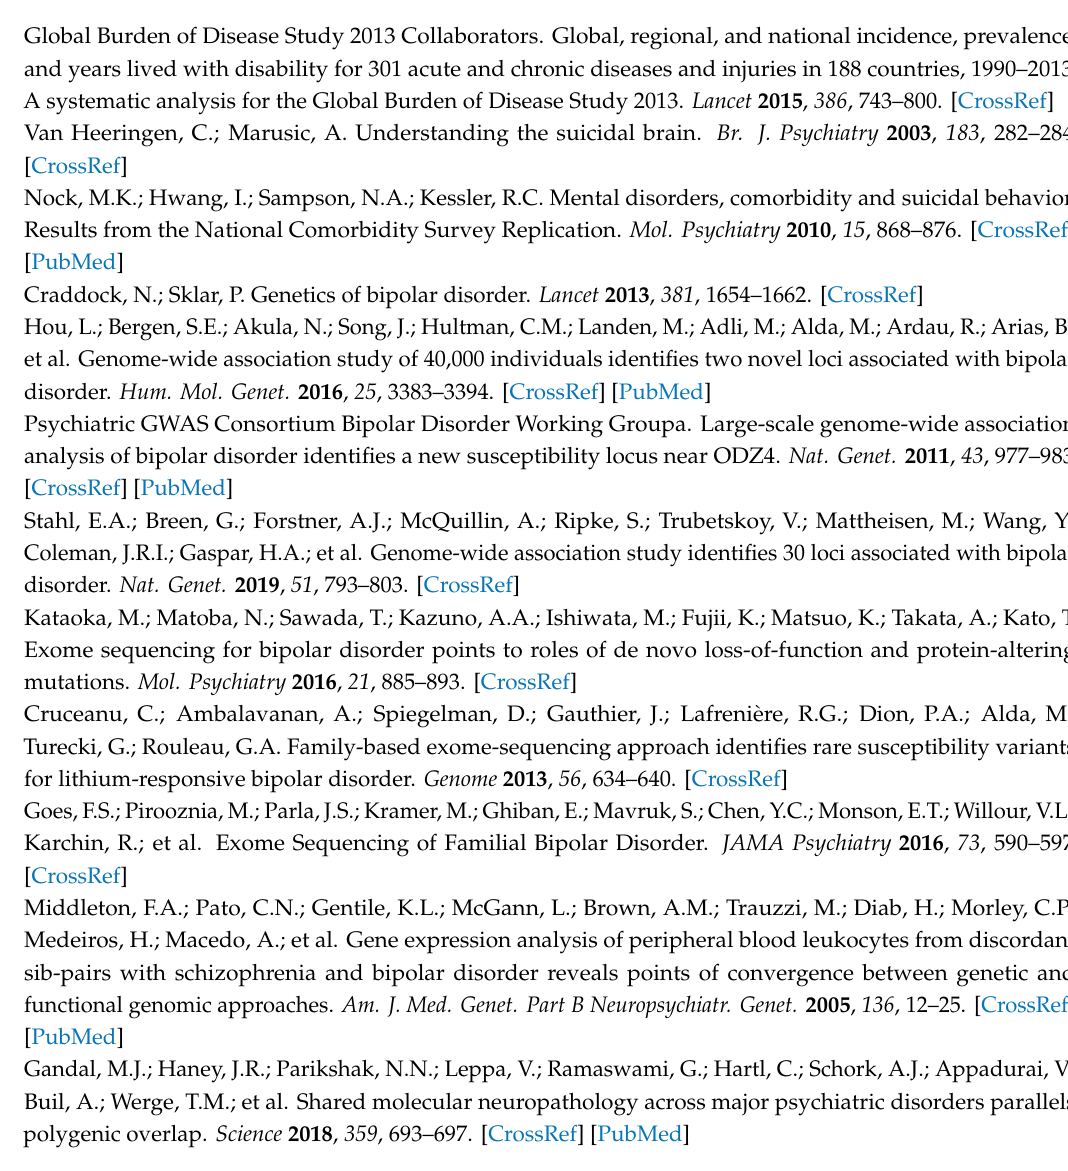
brain. Figure S5: Alternative splicing (AS) case-control comparisons. Figure S6: GO term enrichment analysis of the unique and common events in BPD and controls for each of the AS classes. Figure S7: lncRNAs. Table S1: Detailed phenotypic